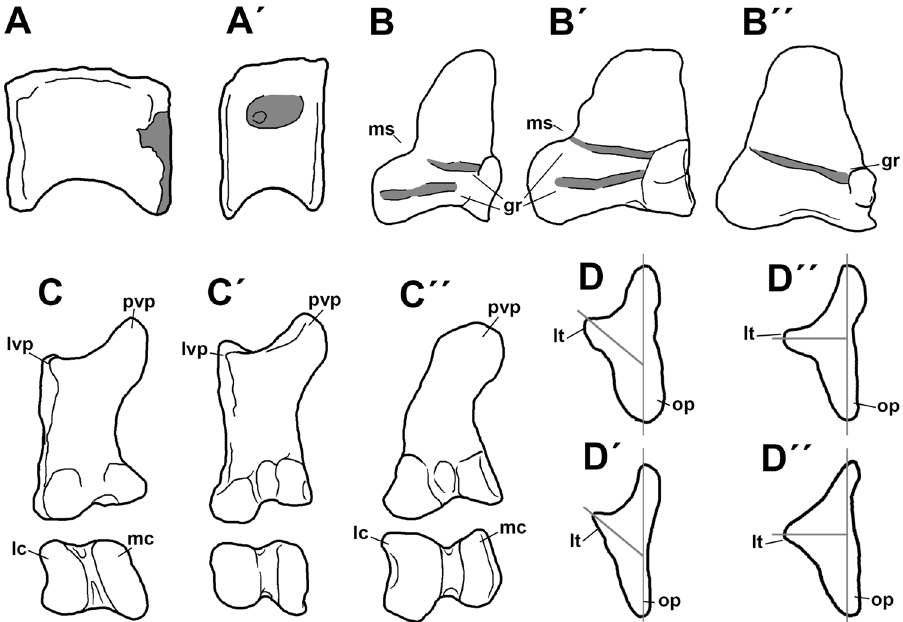
Figure 17. Comparative drawings of potential features supporting a natural clade of South American megaraptorids. A, dorsal vertebra of Fukuiraptor ( A ) and Aerosteon ( A´ ). B, anterior view of astragalus of Vayuraptor ( B ), Australovenator ( B´ ) and Aerosteon ( B´´ ). C, dorsal (up) and distal (down) views of first of Australovenator ( C ), ´ Rapator´ ( C´ ) and Megaraptor ( C´´ ). D, proximal view of ulna of Australovenator ( D ), a Megaraptoridae indet from Australia [NMV P186076] ( D´ ) and Megaraptor ( D´´ ). Abbreviations: gr, groove; lc, lateral condyle; lt lateral tuberosity; lvp, lateroventral process; mc, medial condyle; ms, medial shelf; op, olecranon process; pvp, posteroventral process.